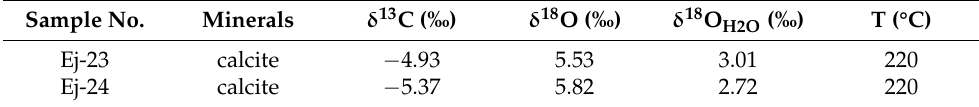
Table 7. Carbon and oxygen isotope data of calcite from the Eunjeok Au–Ag deposit.